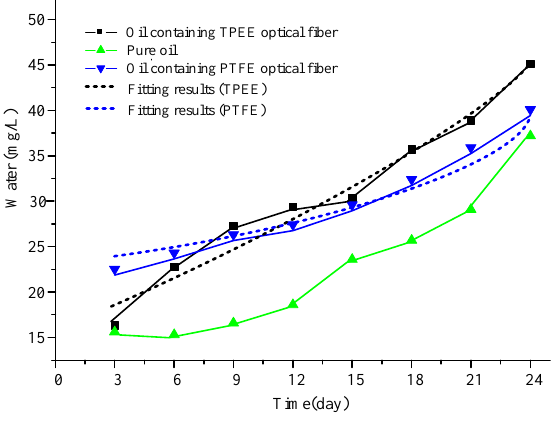
Figure 4. Water content of oil.